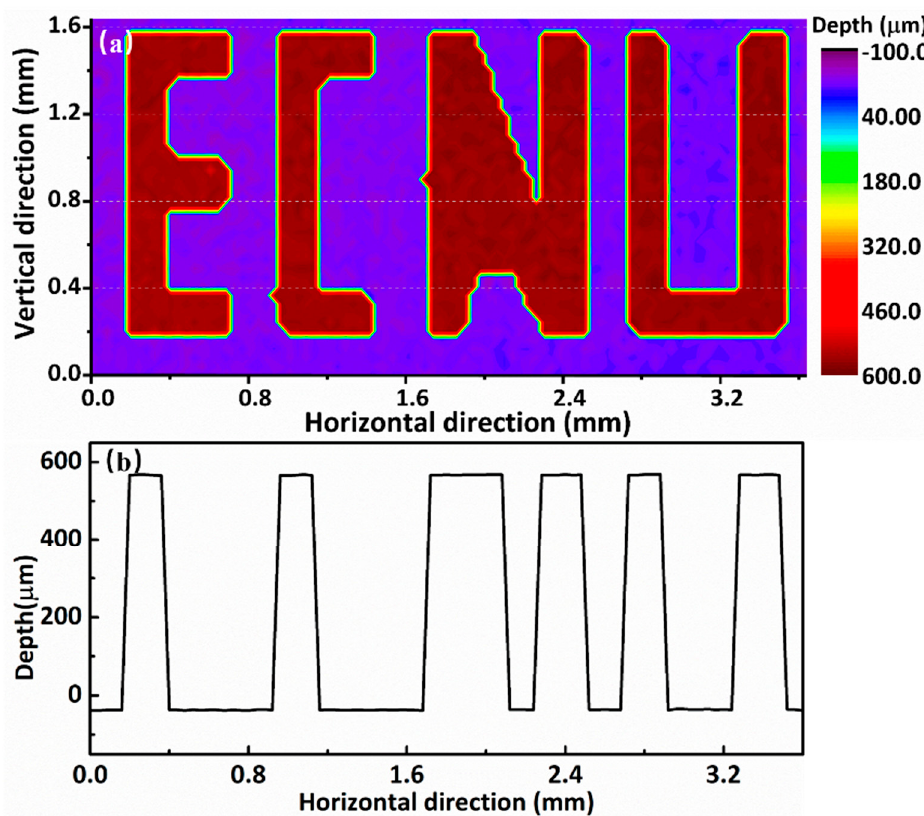
Figure 6. Surface mapping of the letter chain with the depth information calculated after 2D scanning. ( a ) The image of the ‘ECNU’ logo; ( b ) The depth line at 1.2 mm of vertical direction.